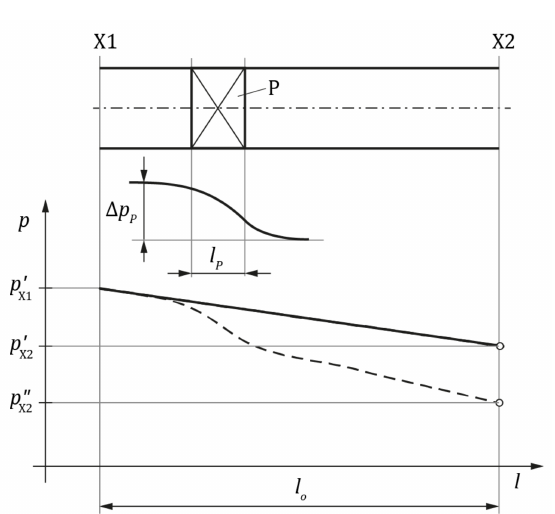
Figure 4. Pressure loss between cross-sections 1 and 2 [29], where P is an obstacle, l p is the length of the obstacle, ∆ p p is the loss at the obstacle (loss focused locally), ( p (cid:48) section (loss evenly distributed) and ( p (cid:48)